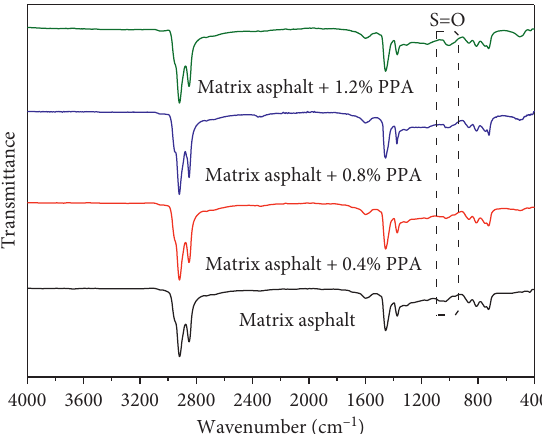
Figure 10: FTIR spectra of modified asphalt with different PPA content after TFOT aging (which showed in the dashed border denoted for the selected range of near 1030cm − 1